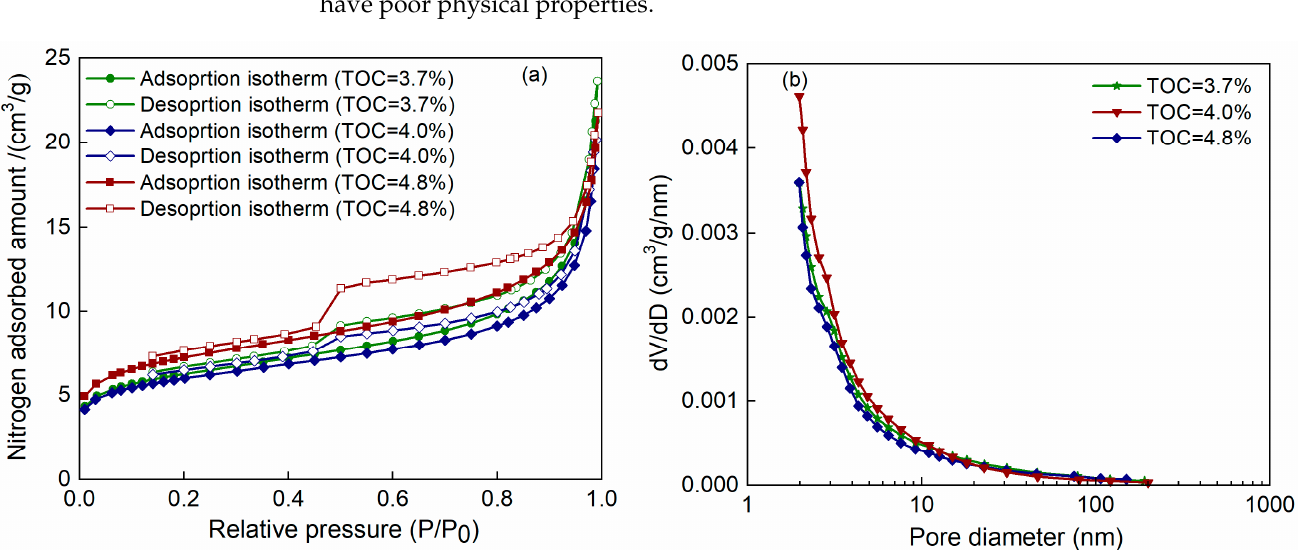
Figure 7. ( a ) The N 2 adsorption-desorption isotherms of the investigated gas shales at the Anchang syncline and ( b ) pore size distribution of shales determined by nitrogen adsorption